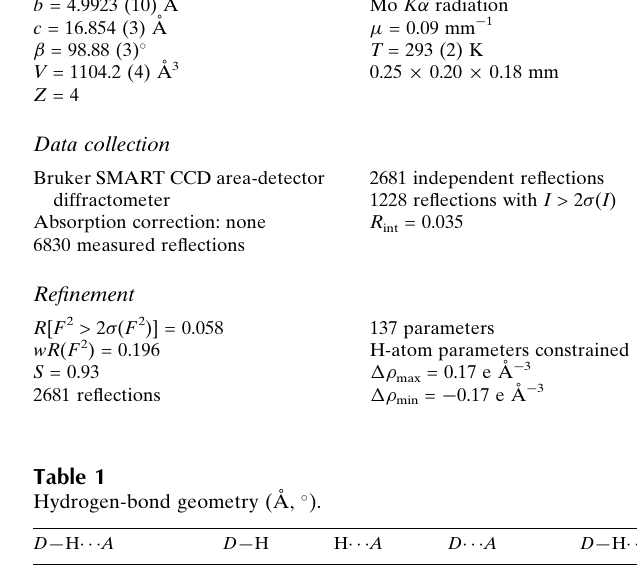
1-(4-methoxyphenyl)-